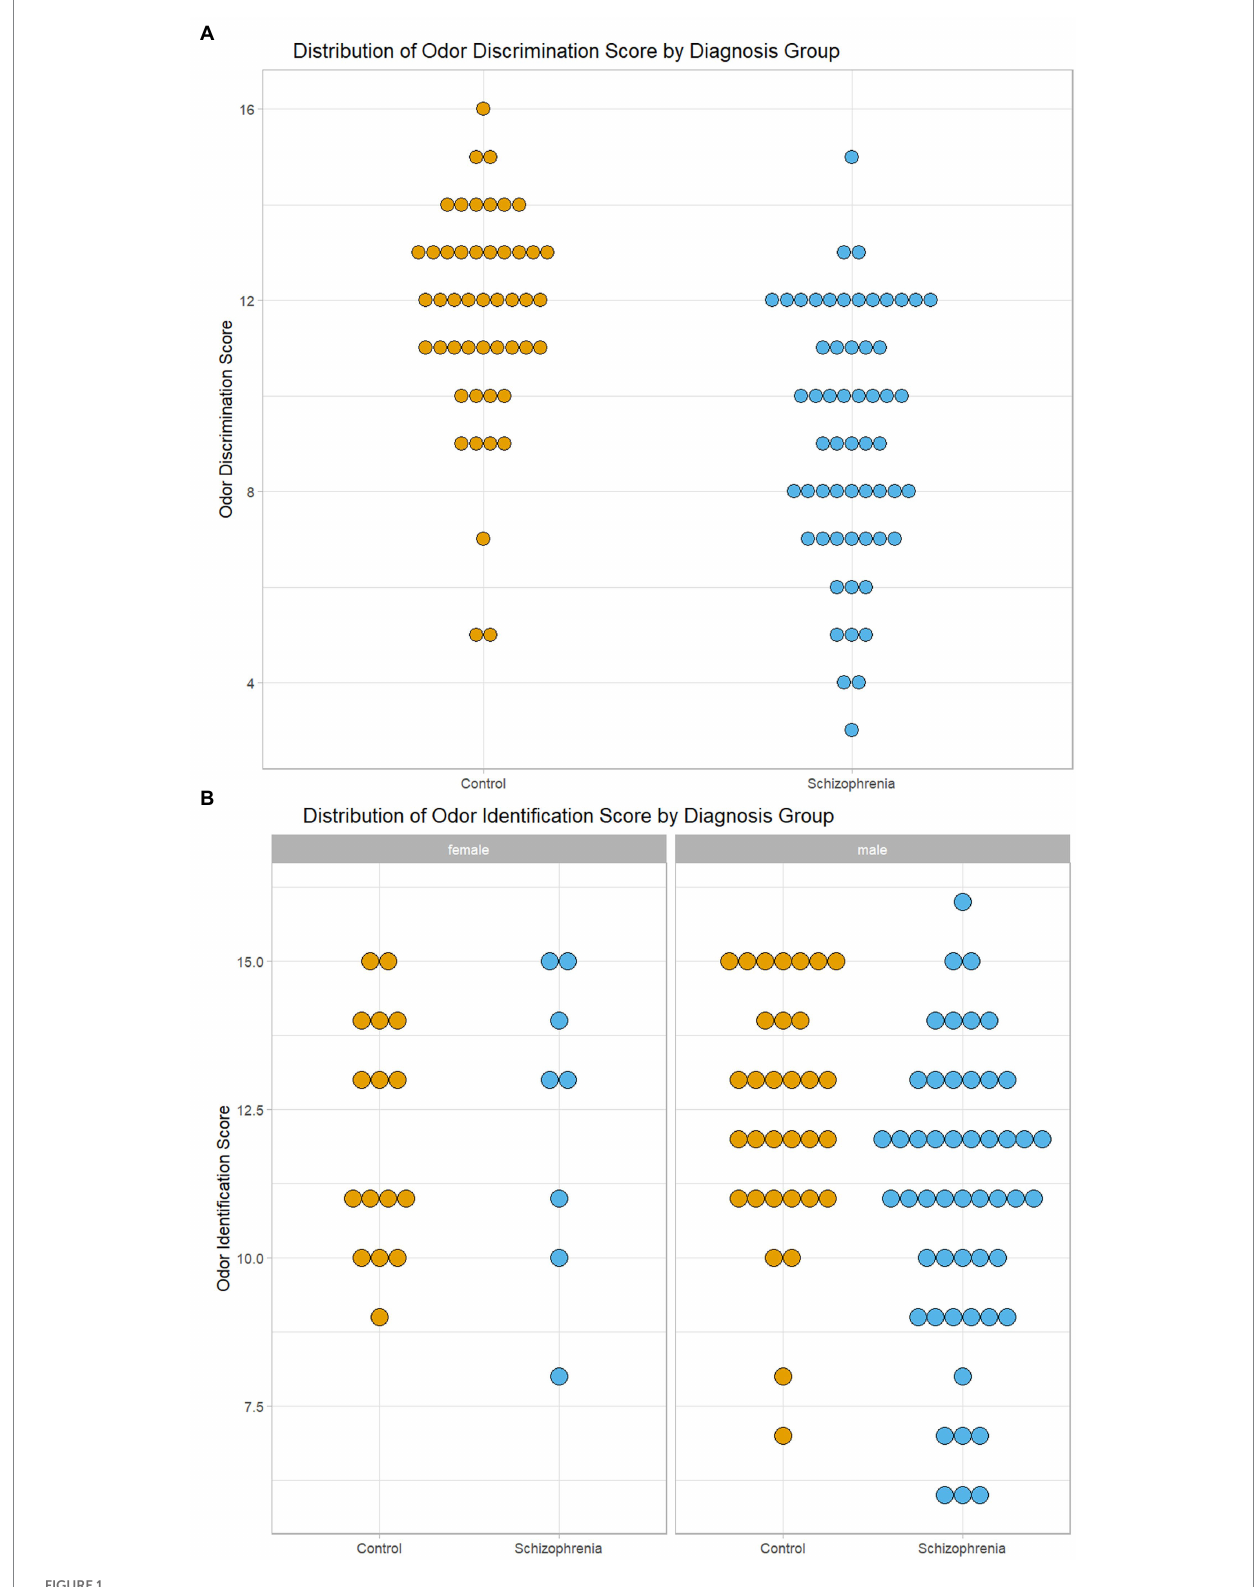
FIGURE 1 Graphical Display of Distribution of Odor Scores in Subjects with Schizophrenia and Controls. (A) Distribution of Odor Discrimination Scores in Subjects with Schizophrenia and Controls. (B) Distribution of Odor Identification Scores by Sex in Subjects with Schizophrenia and